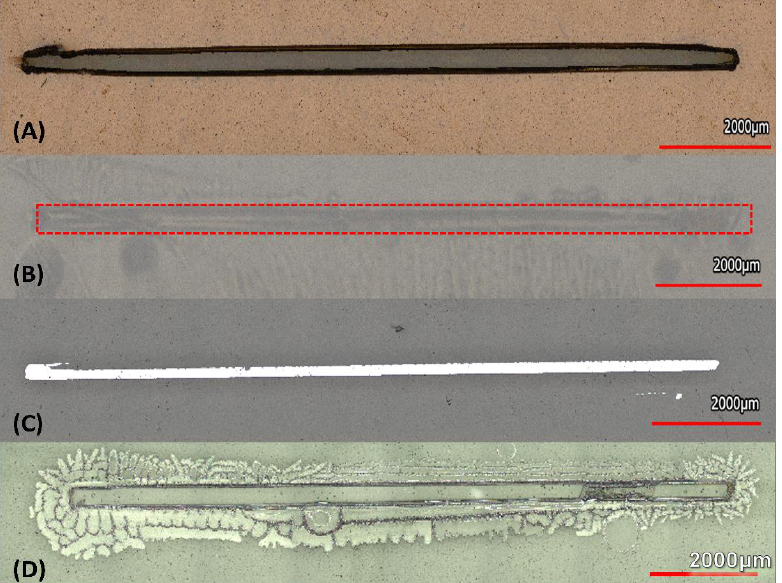
Figure 4. Design to device for: ( Left ) Straight Channels, ( Center ) Serpentine Channels, ( Right ) Square Channel Feature Sizes.